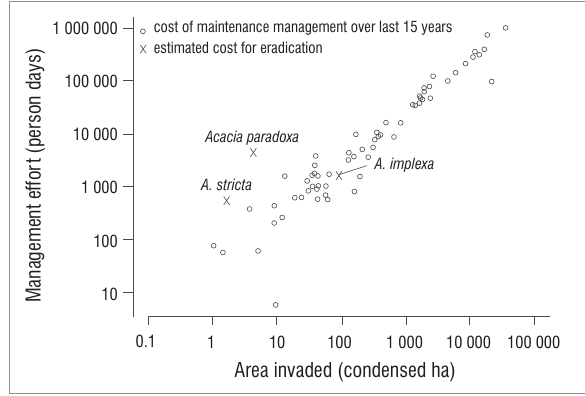
The relationship between the effort spent by the Working for Water Programme (WfW) on alien plant clearing and the size of the infestation (in terms of total condensed